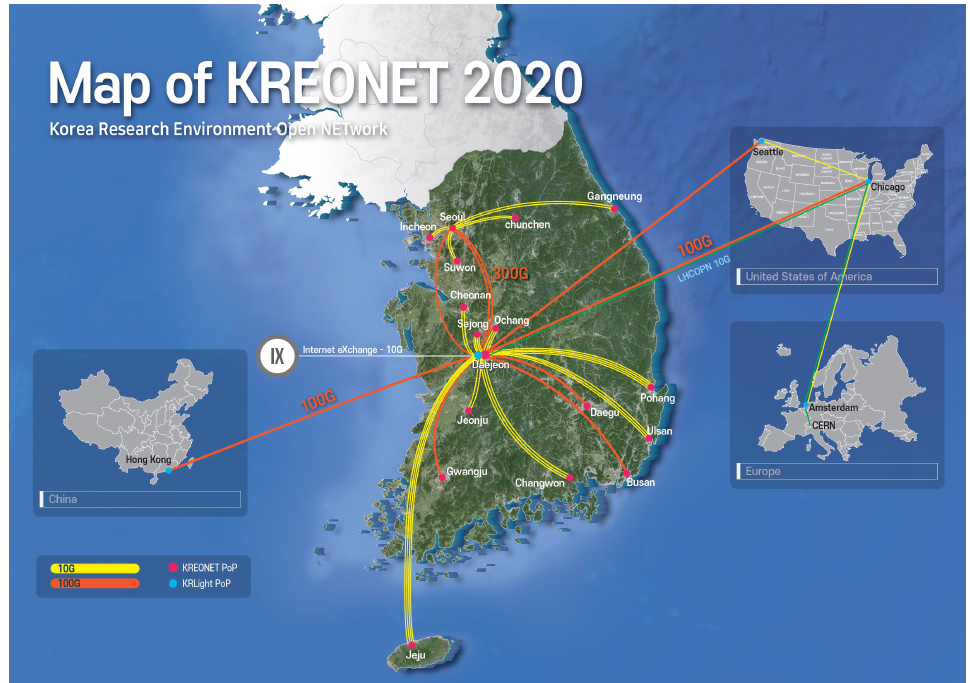
Figure 3. Network map of KREONET, comprising 17 regional centers nationwide and 4 international PoPs worldwide [14].